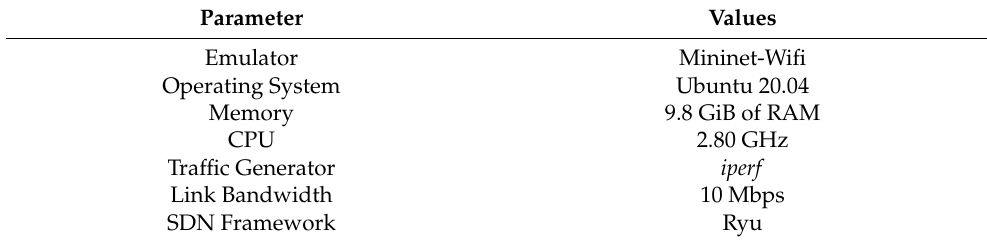
Table 1. Technical aspects of